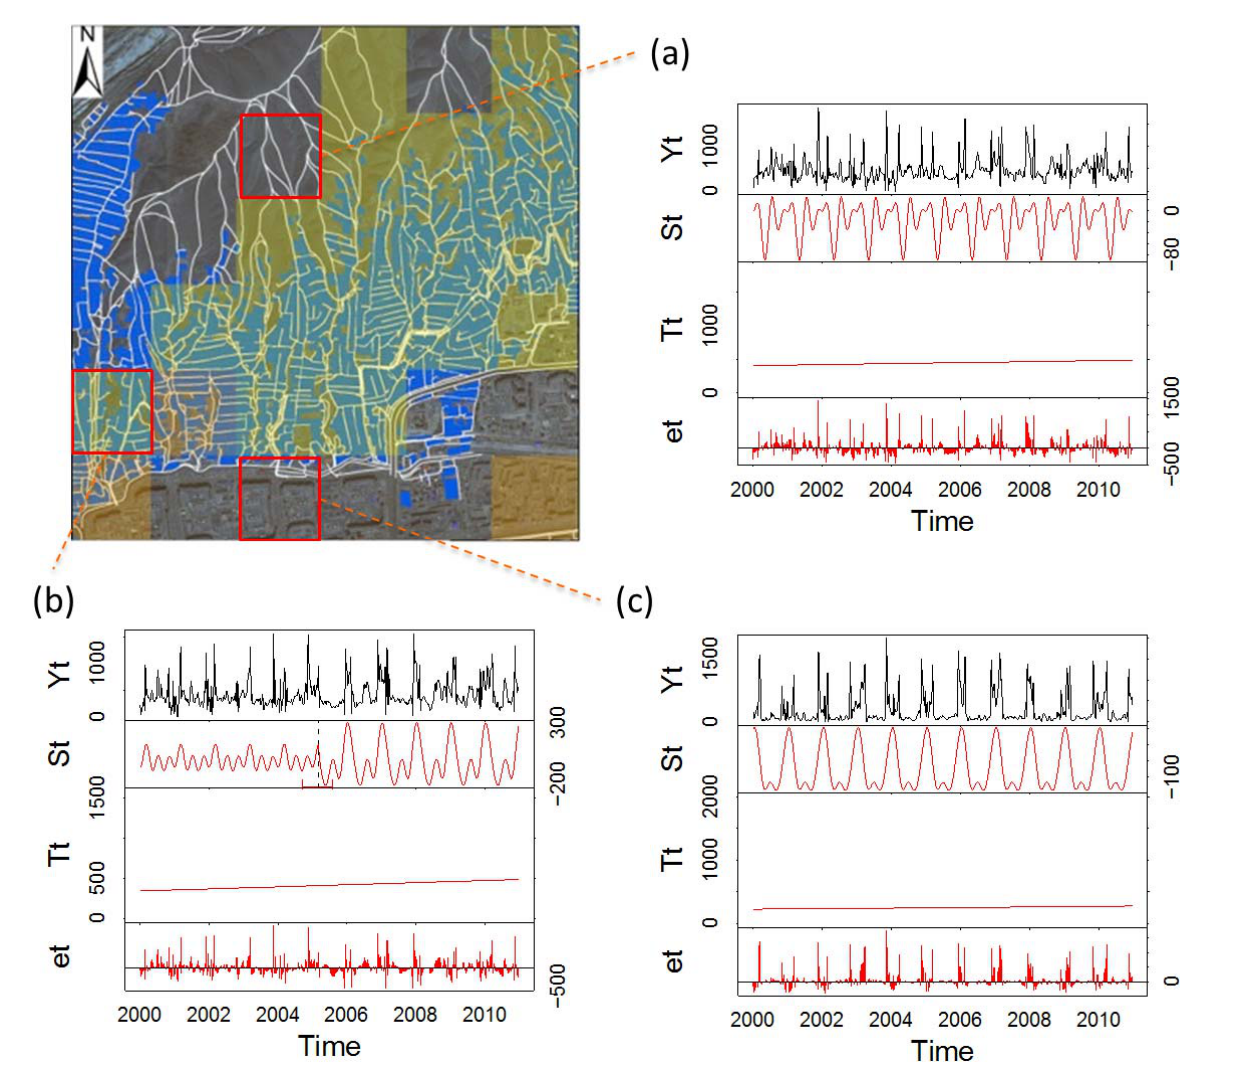
Figure 7. Results of applying BFAST to sample sites: ( a ) open land; ( b ) area converted from open land to ger-area; and ( c )